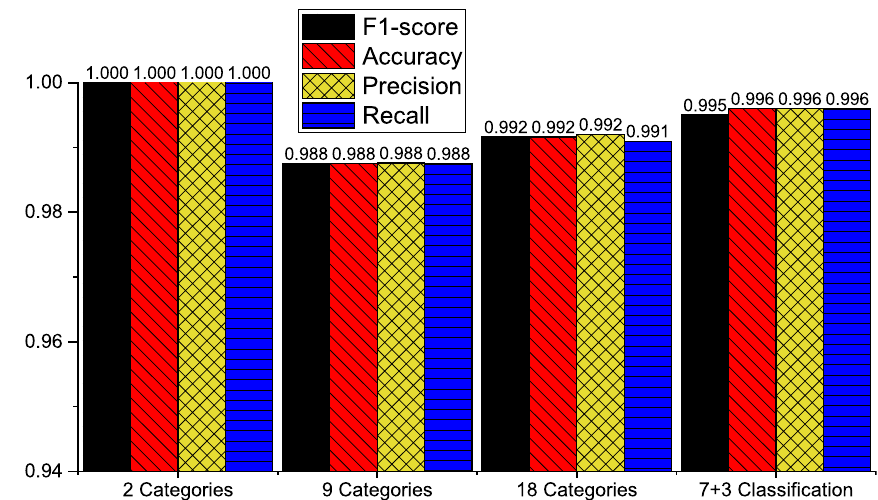
Fig. 3 Experimental Results of HexCNN-1D Model